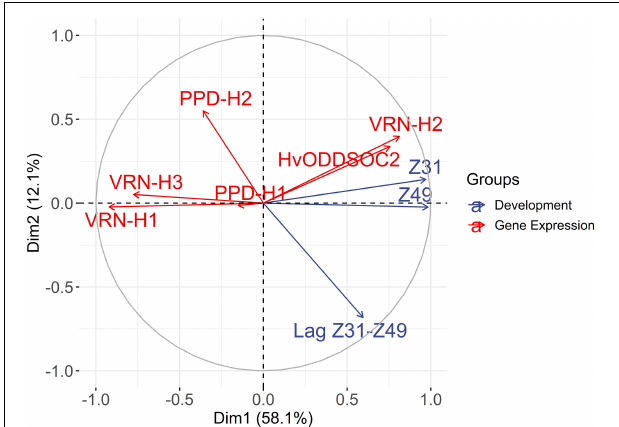
FIGURE 5 | Multiple factorial analysis (MFA), variable correlation circle. The plot shows the correlation of the quantitative variables with the MFA axes. Variables related to developmental phases are depicted in blue and variables related to gene expression are depicted in red. The expression of flowering promoters VRN-H1 , PPD-H1 (ns), VRN-H3 , and PPD-H2 shows a negative correlation with the length of developmental phases. On the contrary, the expression of flowering repressors VRN-H2 and HvODDSOC2 shows a positive correlation with the length of developmental phases and negative correlations with the promoters, positioned in the opposite semicircle. The first dimension represents mainly the time to reach the jointing stage and the genes that influence it, whereas the second dimension is more related to the late reproductive